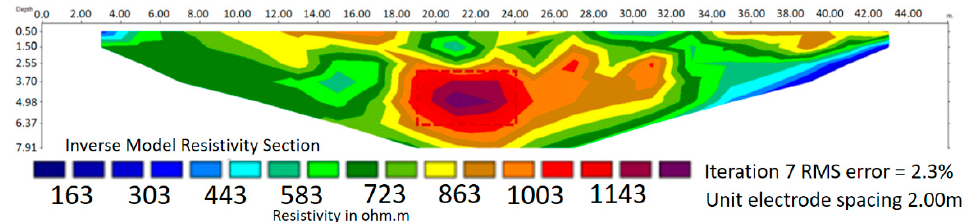
Figure 3. L1 result.